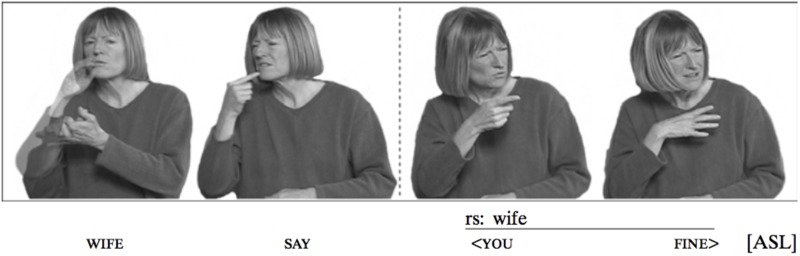
Referential shift of upper body in American Sign Language (reprinted with permission from Lillo-Martin, 2012).